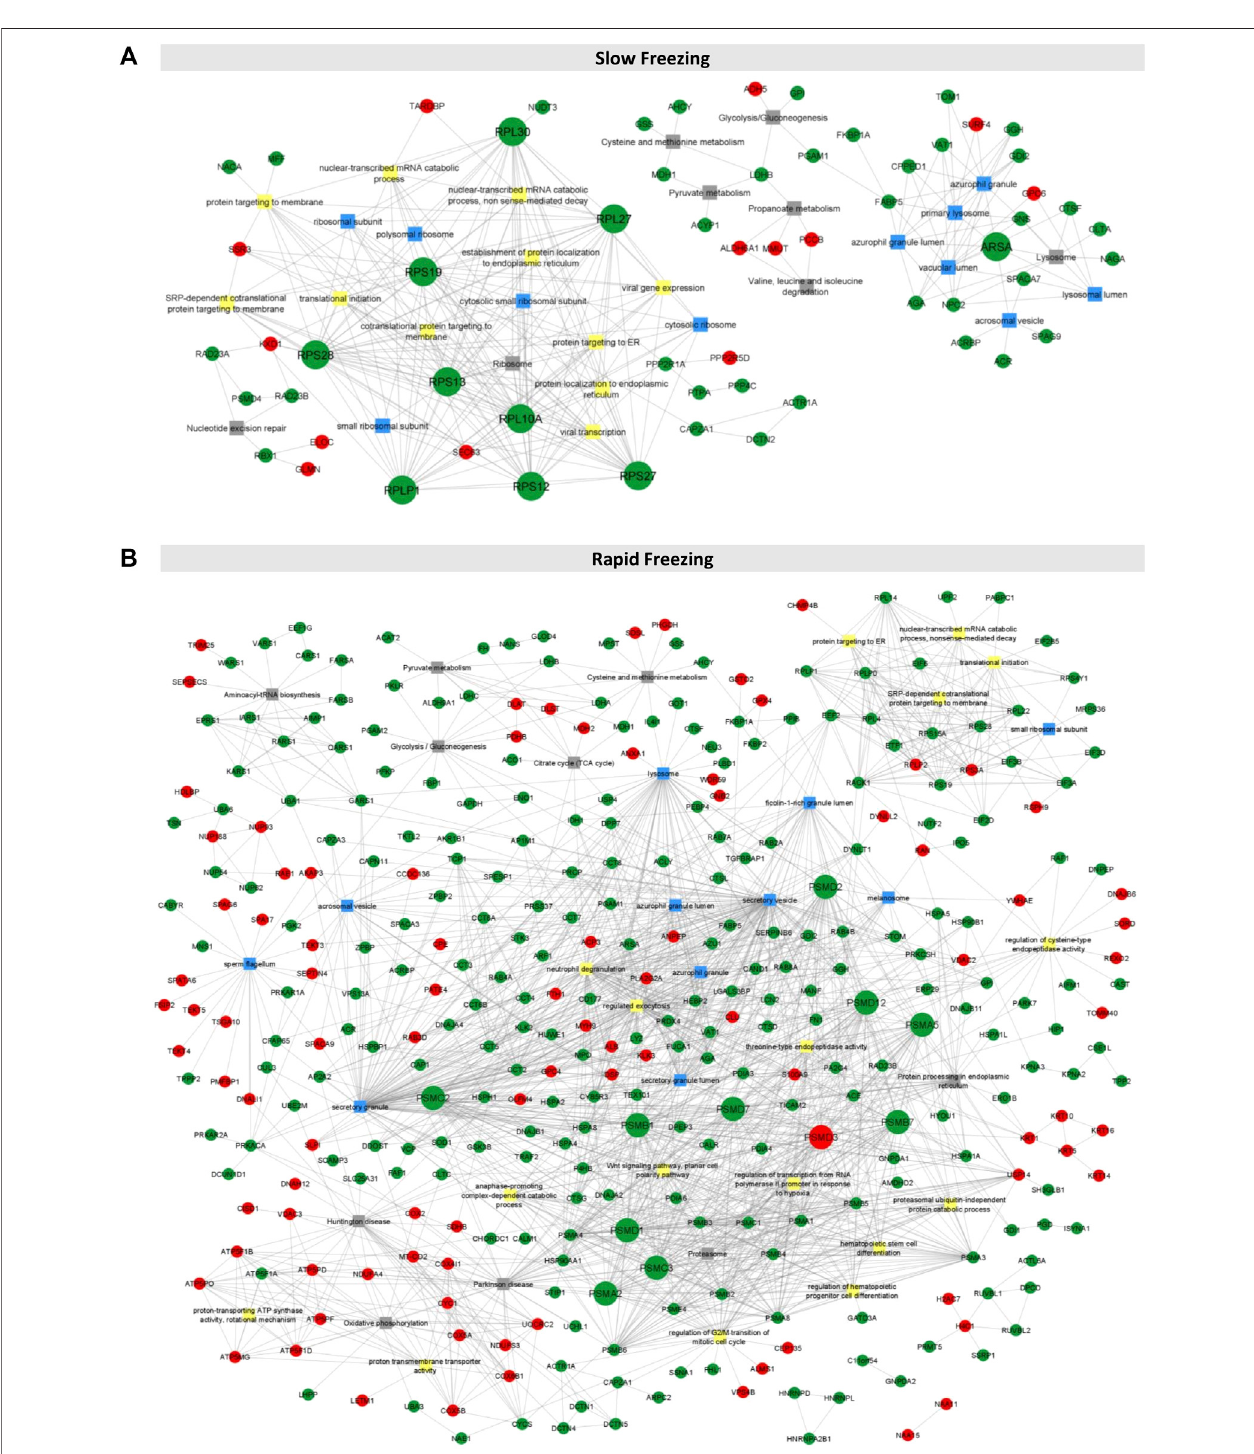
FIGURE 2 | Integrative networks for rapid and slow freezing groups. (A, B) The integrative networks constructed for slow and rapid freezing groups using informationfromenrichmentanalyses(top10biologicalprocesses,cellularcompartment,andKEGGtermsaswellascommontermstobothgroupsandsperm-related terms) and PPIs data. Only connected proteins were represented (N (cid:1) 60 and N (cid:1) 344 for slow and rapid freezing, respectively). Each node corresponds to a DEP (represented by the gene name), being the red nodes increased proteins and the green nodes decreased proteins. The squares represent GO or KEGG terms (yellow squares for biological processes, blue squares for the cellular compartment, and grey squares for KEGG pathways). The nodes with bigger sizes represent the proteins with higher degree.